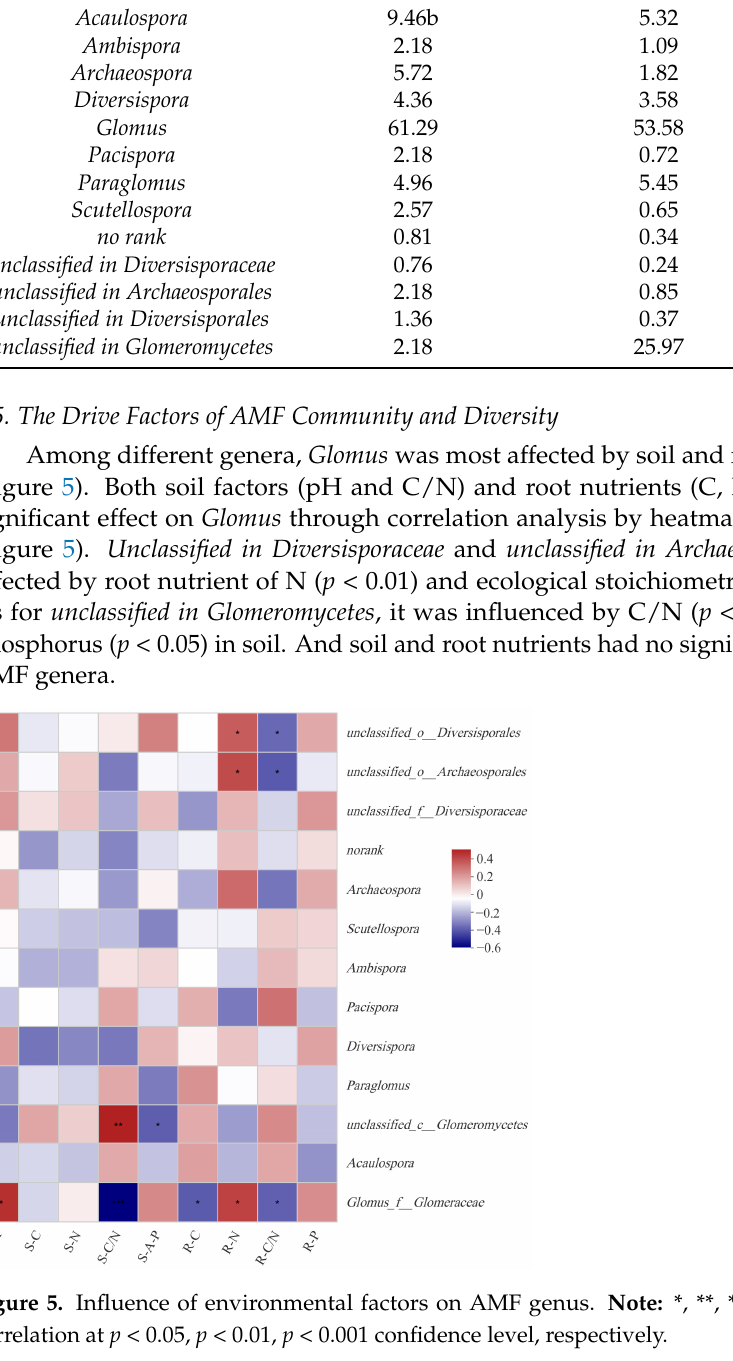
Figure 6. The relationships among elevation, soil factors (C, N, P, C/N, and pH), plant factors (C, N, P, and C/N), and AMF diversity indices are based on OTU level. Note: The effect of altitude on soil